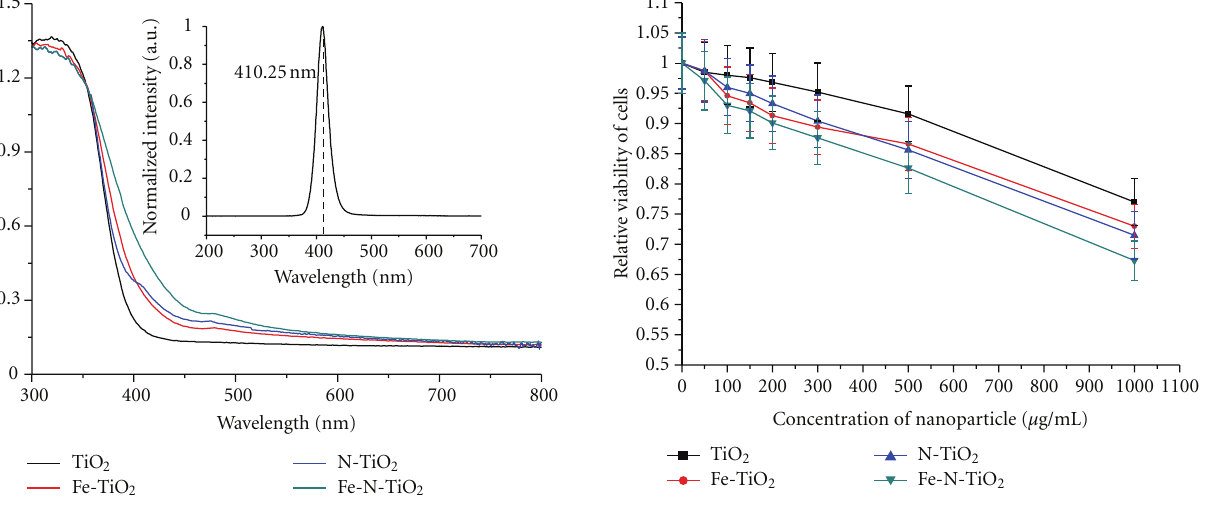
Figure 5: The influence of Fe-N-TiO 2 concentrations on the rela- tive viability of HL60 cells. Data are presented as the means ± SD from five independent measurements. ∗ P values are less than 0.05 as compared with untreated control